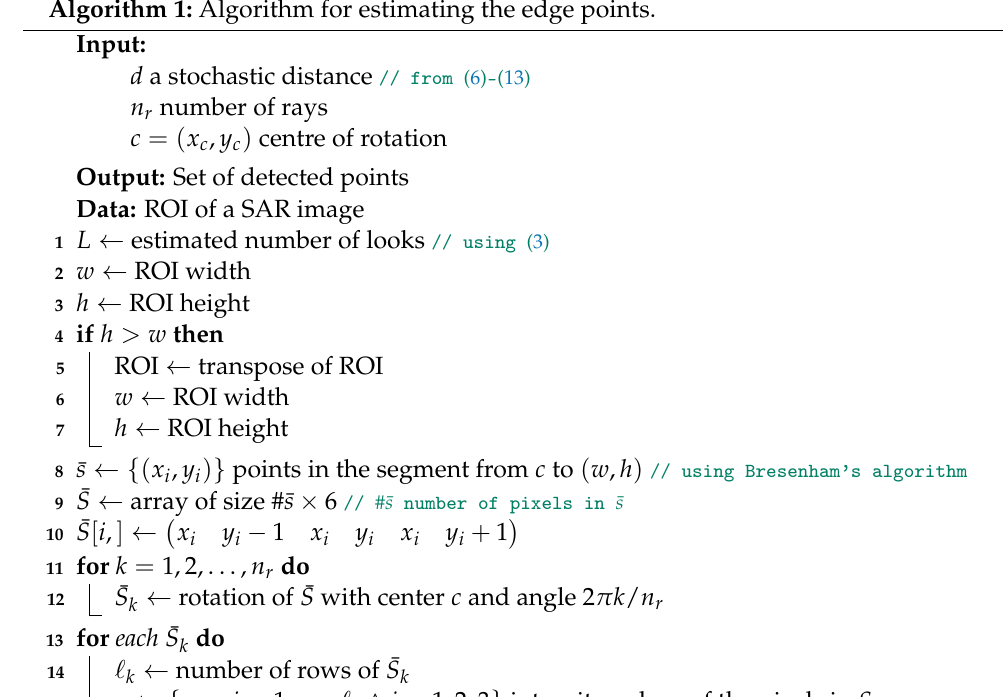
Algorithm 1: Algorithm for estimating the edge